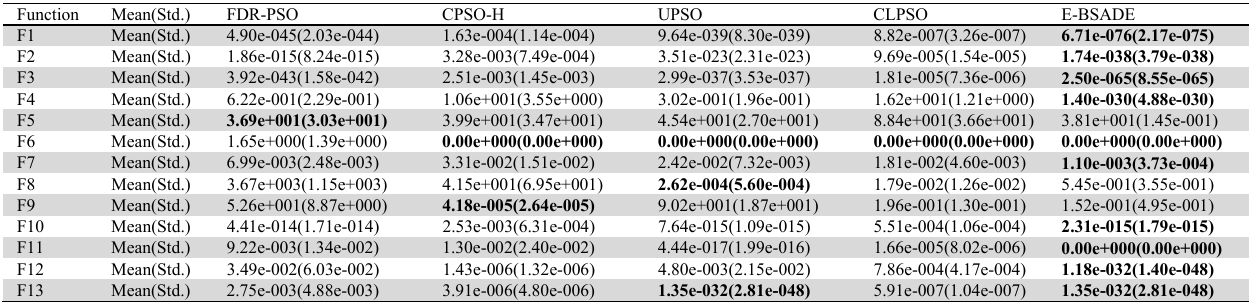
Comparative statistical results of 13 benchmark function of E-BSADE with other state-of-the-art PSO